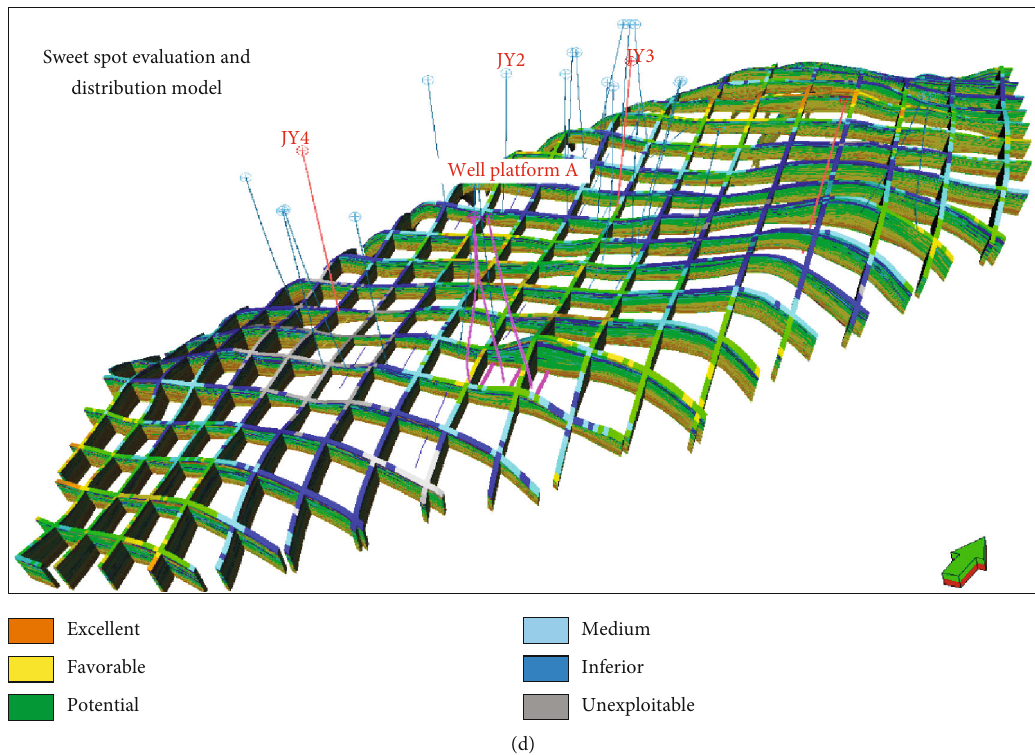
Figure 12: Shale reservoir matrix property models. (a) Brittle mineral content (the main mineral is quartz) distribution model. (b) TOC model, which shows a clear trend vertically, as well as mineral model. (c) Porosity model, which re fl ects apparent heterogeneity on the plane. (d) Sweet spot evaluation and distribution model based on the establishment of the parameter model.